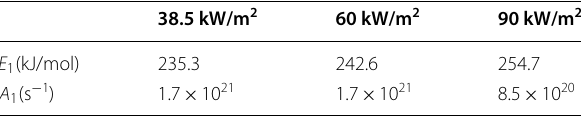
Table 2 Kinetic parameters E 1 and A 1 for different heat flux